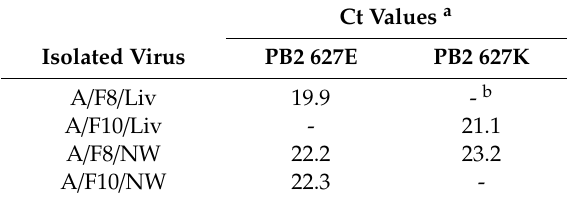
Table A1. PB2 627 SNP analysis of A / Laos ferret-passaged isolates following amplification in eggs. Ct Values a